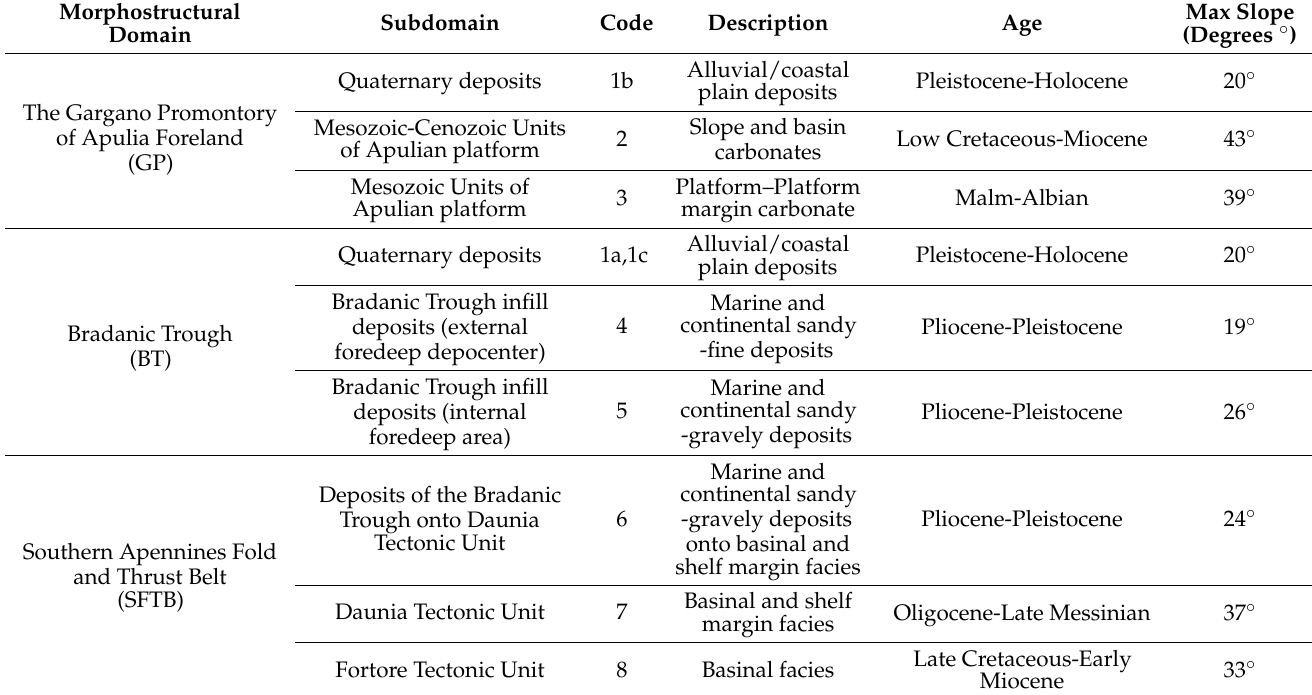
Table 1. Morphostructural domains and respective subdomains constituting the Northern Apulia. For each subdomain, the main features (geological-geomorphological description, age and maximum slope) are summarized together with a representative code also reported in Figure